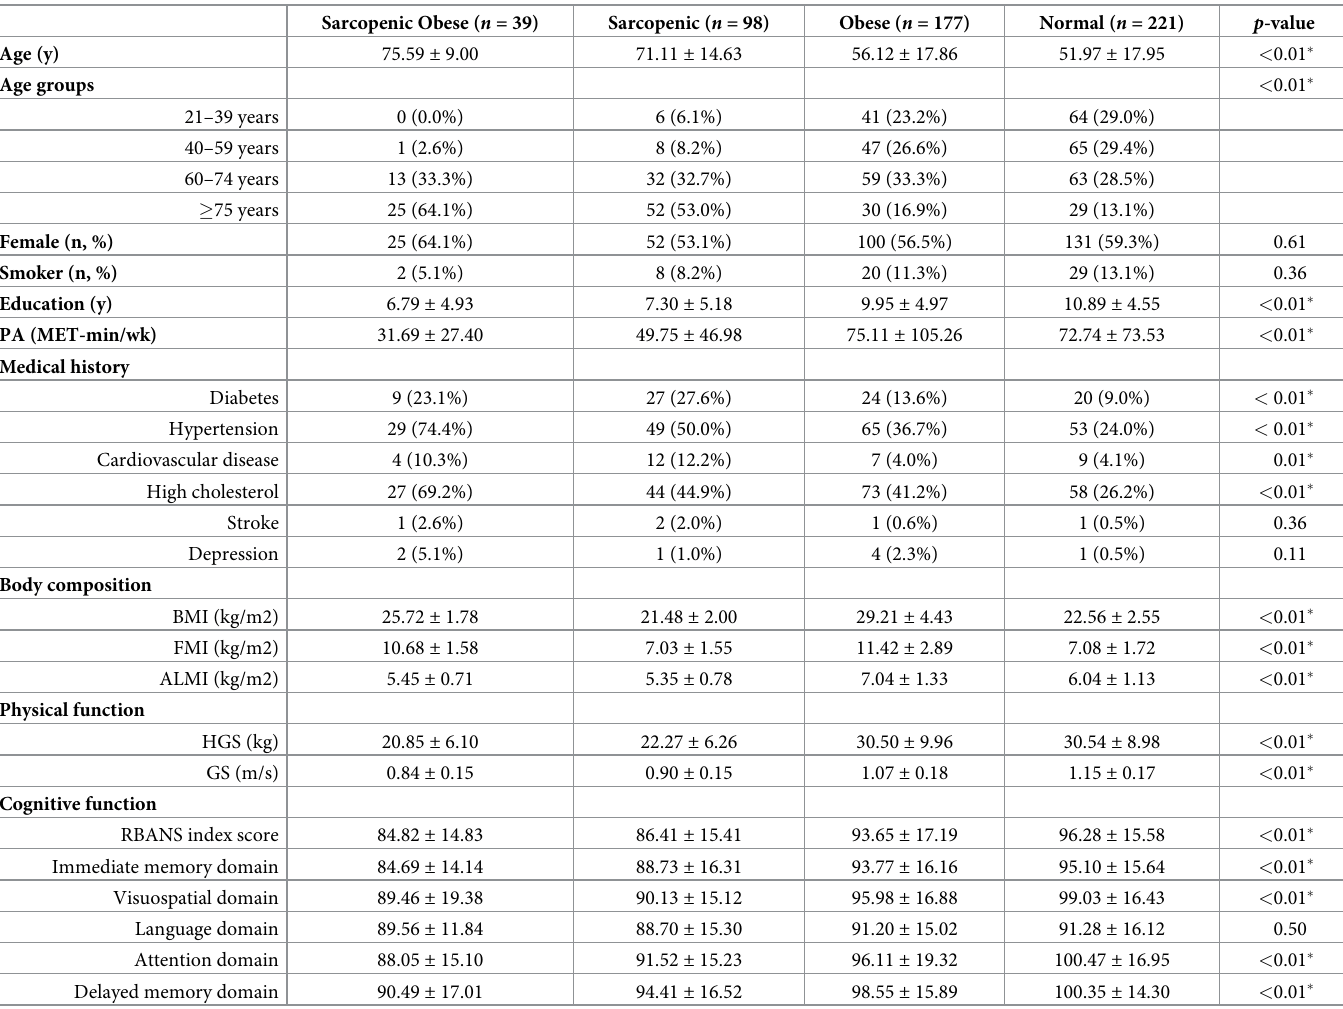
Table 1. Descriptive characteristics of participants by sarcopenia and obesity